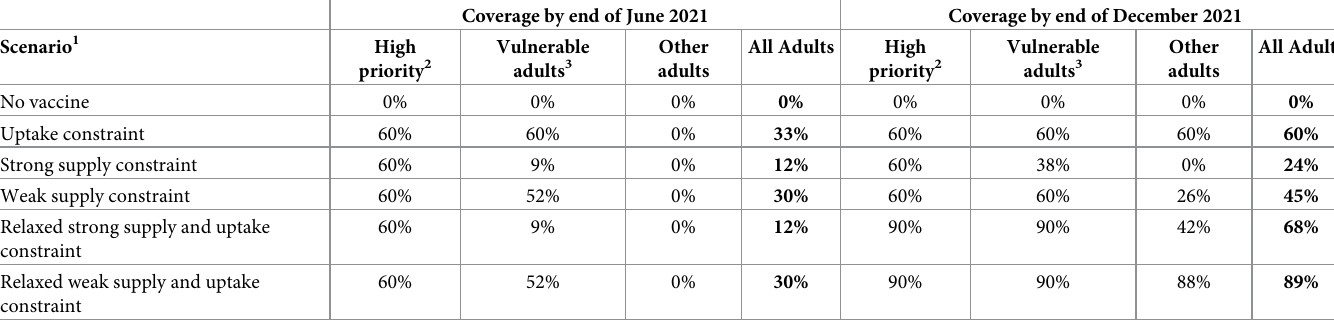
Table 1. Vaccine coverage by June 2021 and December 2021 for three groups